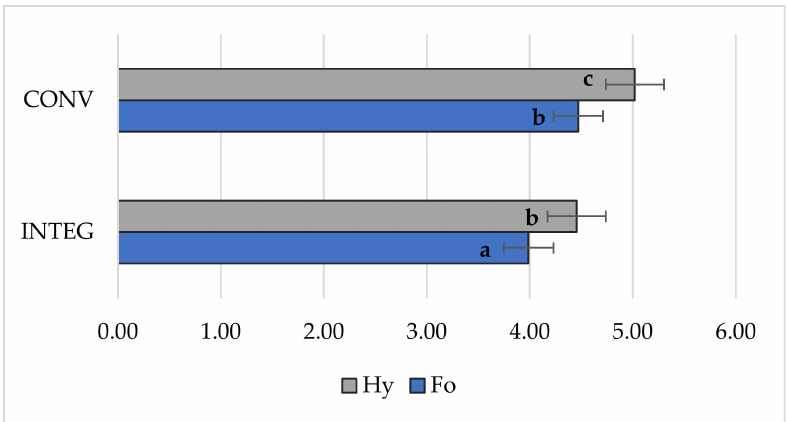
Figure 3. Leaf area index depending on cultivars and cropping systems. The presence of dif- ferent lowercase letters indicates a statistical difference between means (Tukey’s Test, p = 0.05). INTEG—integrated cropping system, CONV—conventional cropping system, Fo—cv. Formacja, Hy—cv.